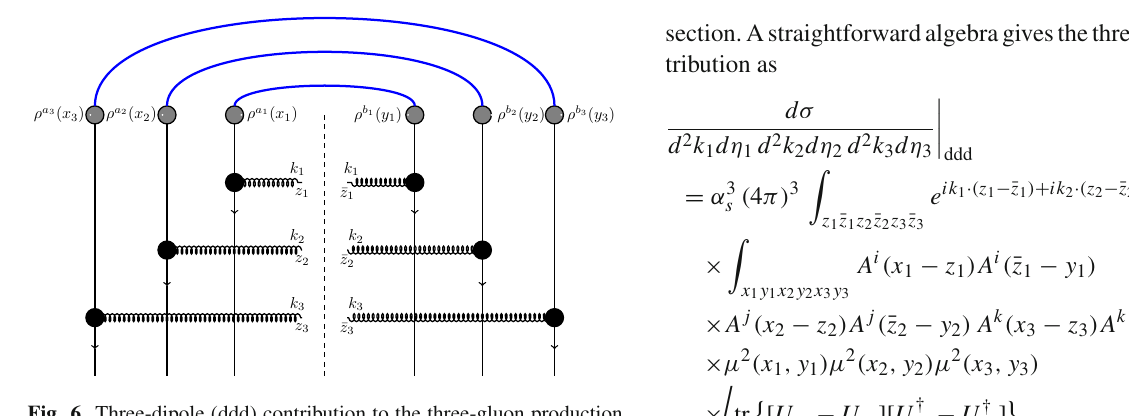
Fig. 6 Three-dipole (ddd) contribution to the three-gluon production cross section